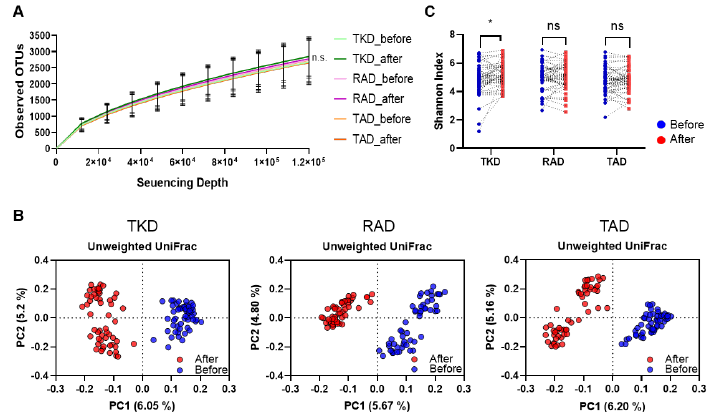
Figure 1. E ff ects of three di ff erent dietary patterns on the diversity of gut microbiota. 16S rRNA gene Figure 1. Effects of three different dietary patterns on the diversity of gut microbiota. 16S rRNA gene sequence analyses of gut microbiome were performed before and after typical Korean diet